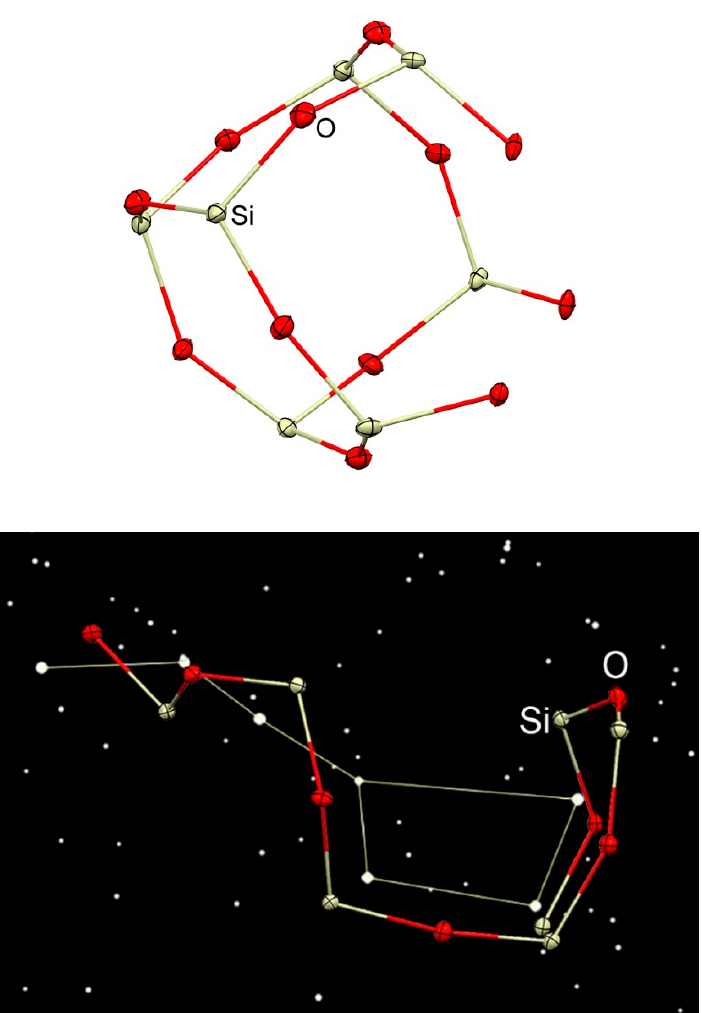
Figure 2. Top: Molecular structure of 2. Center: Non-condensed cubane siloxanolate ligand in 2. Bottom: “Ursa Major” siloxanolate-silanol ligand in 2.